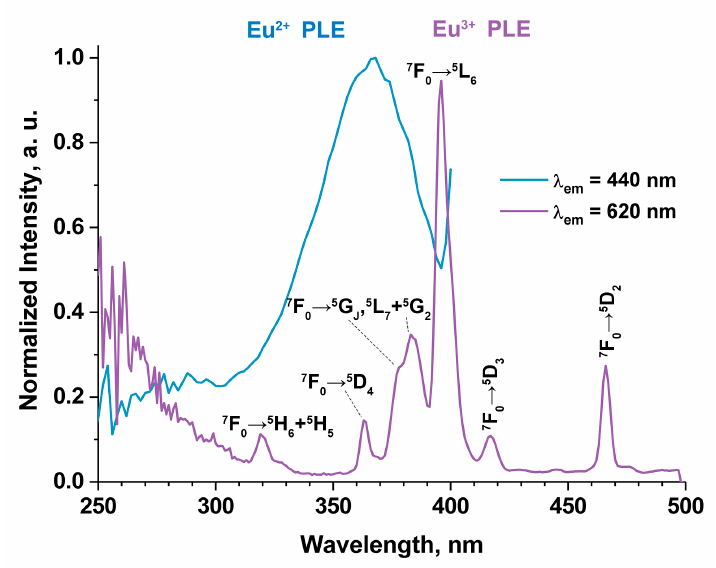
Figure 11. Normalized PLE spectra of Ca 8.2 Mn 0.8 Eu(PO 4 ) 7 at λ em = 440 and 620 nm.